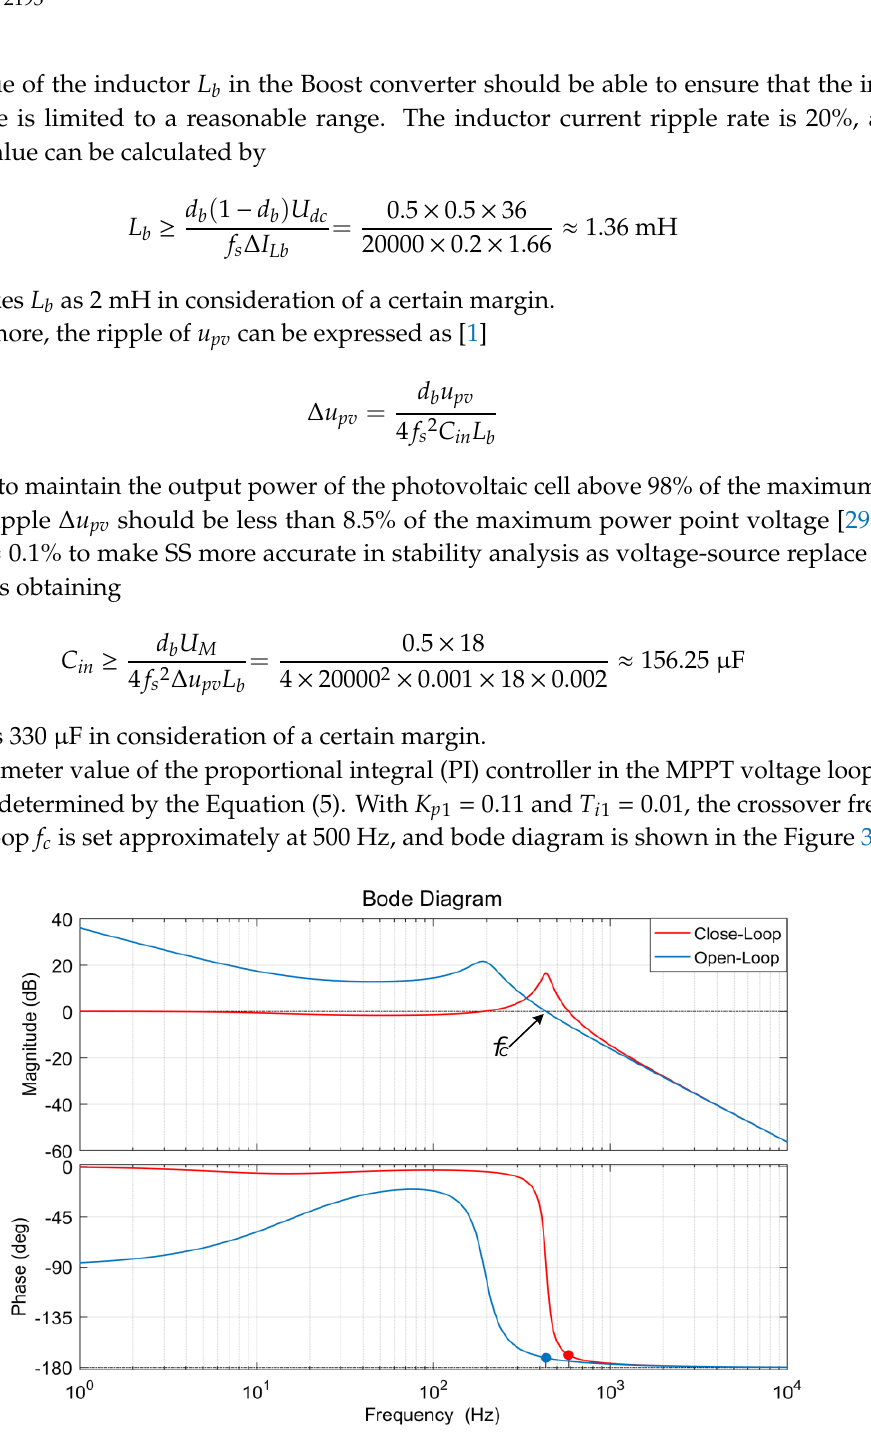
Figure 3. Maximum power point tracking (MPPT) Voltage-Loop Bode Diagram.